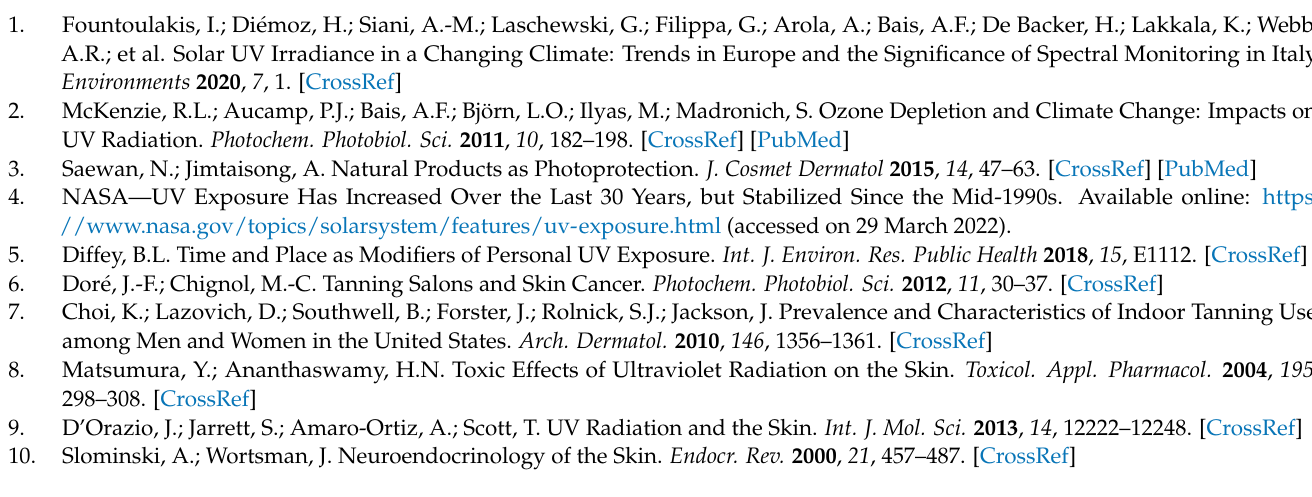
S1: Measurements’ sites; Figure S2: Solar simulator spectral characteristics; Figure S3: Skin elasticity parameters; Table S2: Subjects’ baseline demographic and clinical characteristics; Table S3: UVA- stimulated MDA results; Table S4: Wrinkle length, area, and wrinkle count; Table S5: